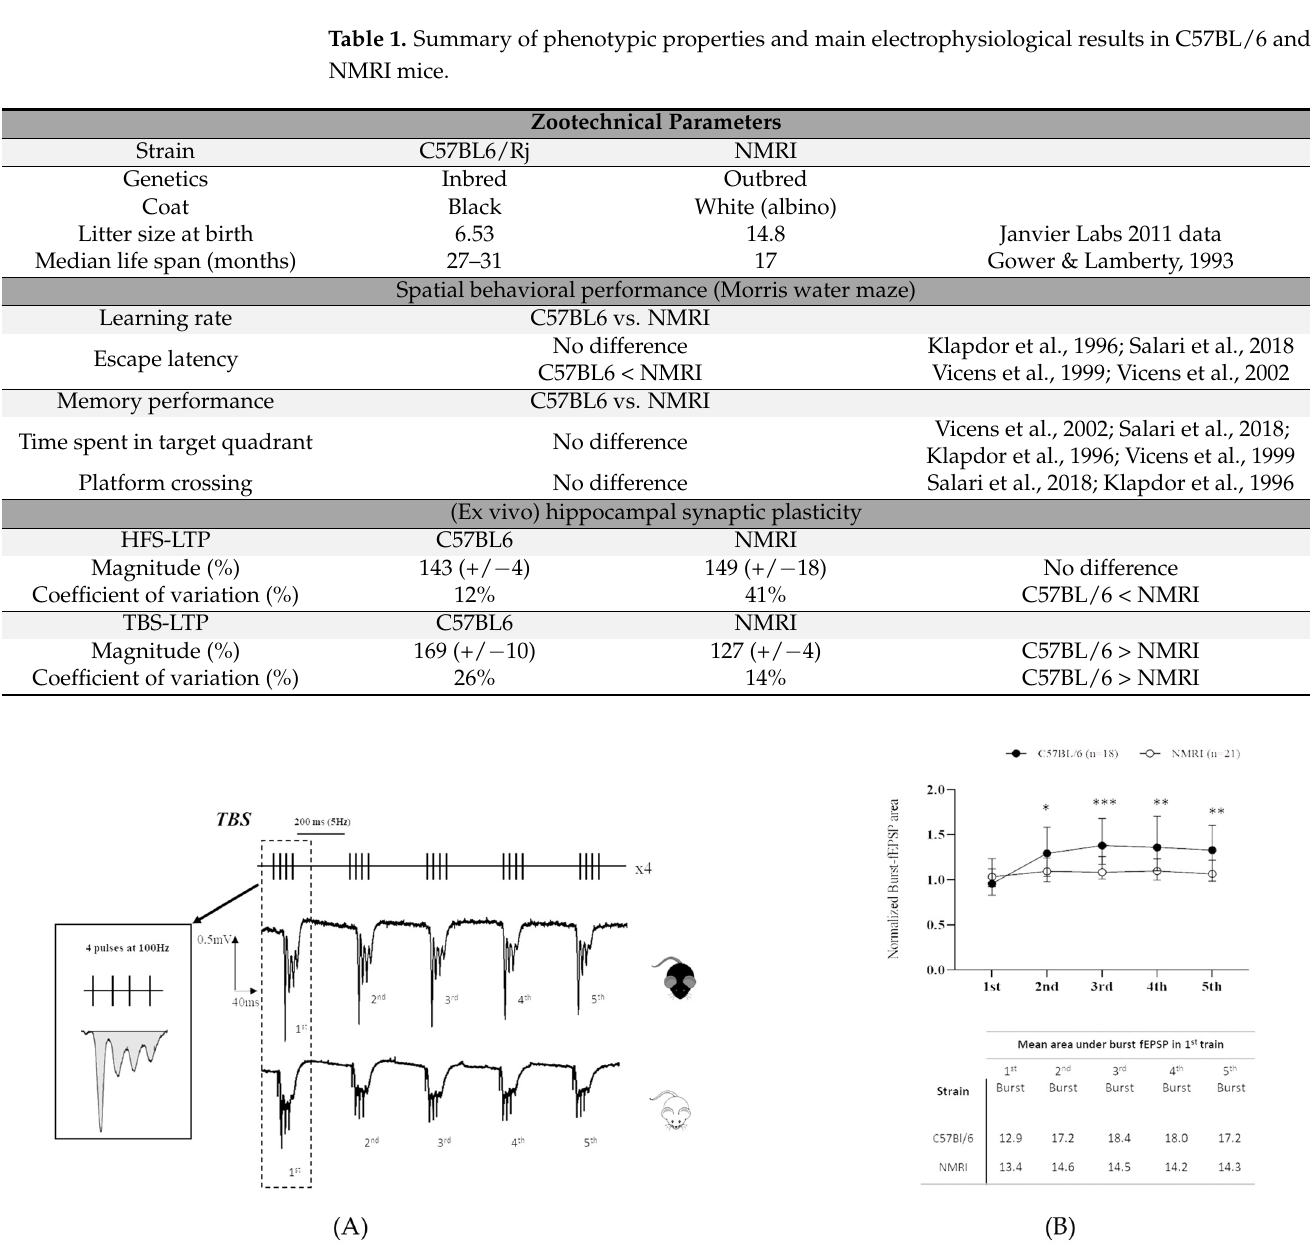
Figure 3. C57BL/6 mice exhibit higher degree of facilitation than NMRI outbred stock during TBS.